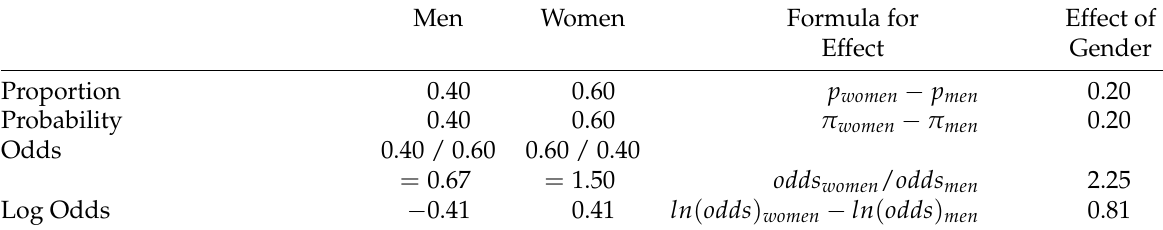
Table 1: Various ways to summarize the effect of gender (woman = 1) on